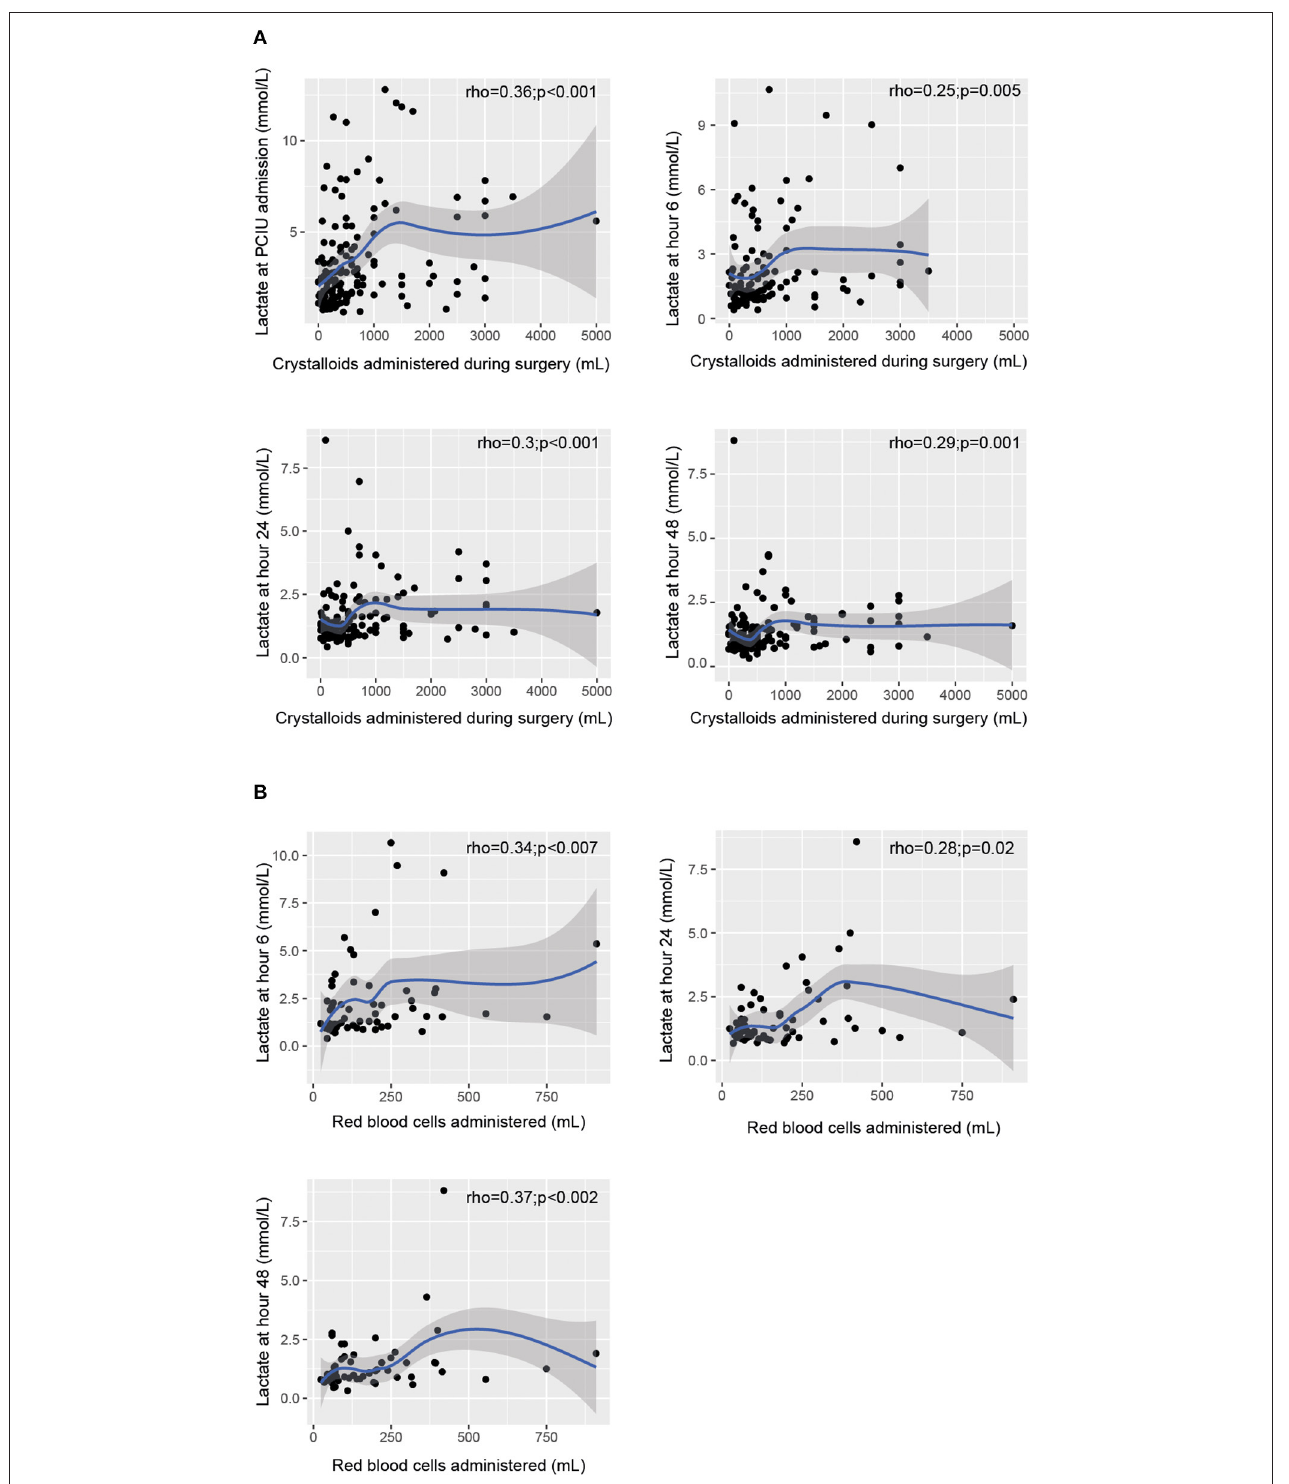
FIGURE 3 | Relationship between serum lactate levels at the various assessment times and the volume of fluids administered during surgery (A) . Relationship between post-operative lactate levels and the volume of red blood cells administered (B) .